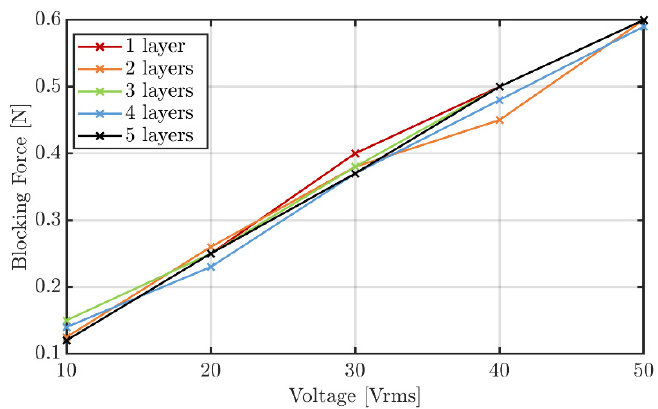
Figure 8. Blocking force of the transducer for different voltages and numbers of active layers.